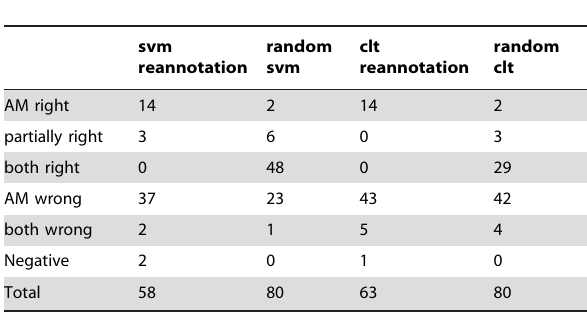
Table 4. Summary of second round reannotation